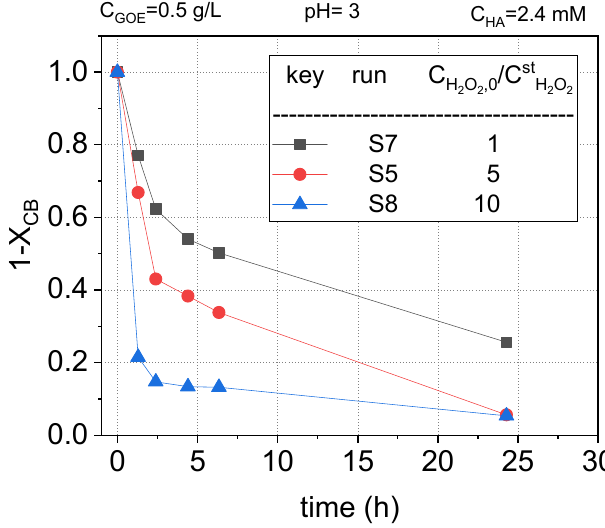
ff erent ( 1 − X CB ) vs. reaction time using di − 1 , and C HA = 2.4 mM, at room